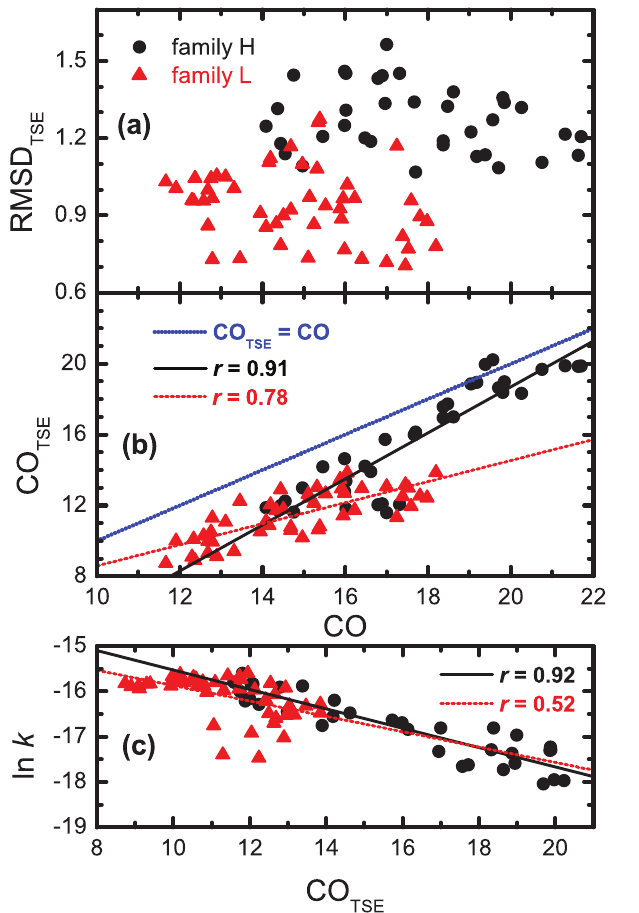
Figure 5. Structural variability in the TSE measured by (a) the RMSD to the native structure (in lattice units) and (b) the relation between the contact order of the TSE and the native contact order. In both families, CO TSE is typically smaller than the CO,